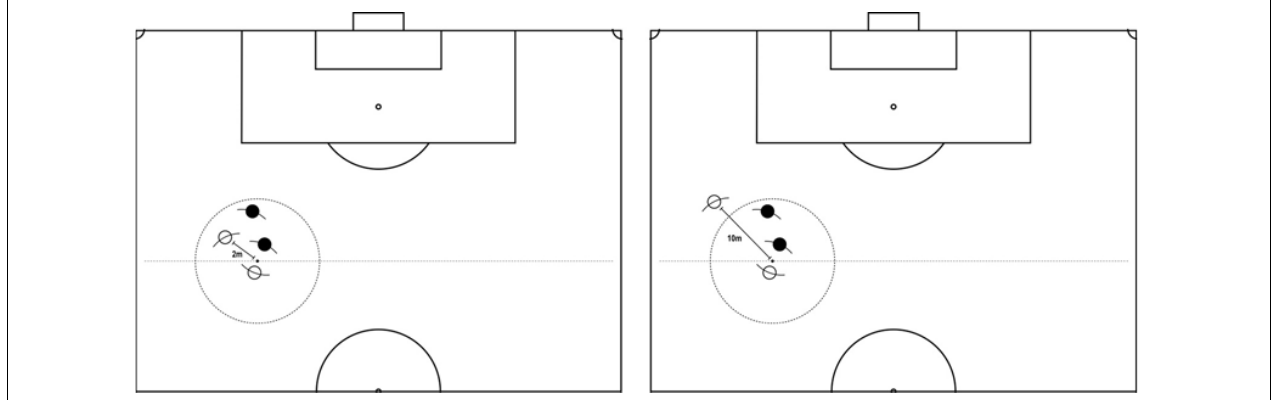
FIGURE 1 | Comparison between creating an option of passing from 2 to 10